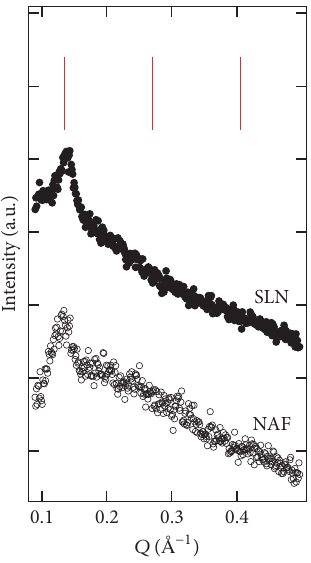
Figure 2: X-ray diffraction profiles observed for nanoparticle dispersions without (black dots) and with NAF (white dots) at 37 ∘ C. The SLN profile has been shifted for clarity. Vertical lines indicate the position of the first 3 peaks expected in the case of a 1D lamellarsymmetry:notethat,intheNAFprofile,thesecondorderof diffraction is almost appreciable, confirming the lamellar